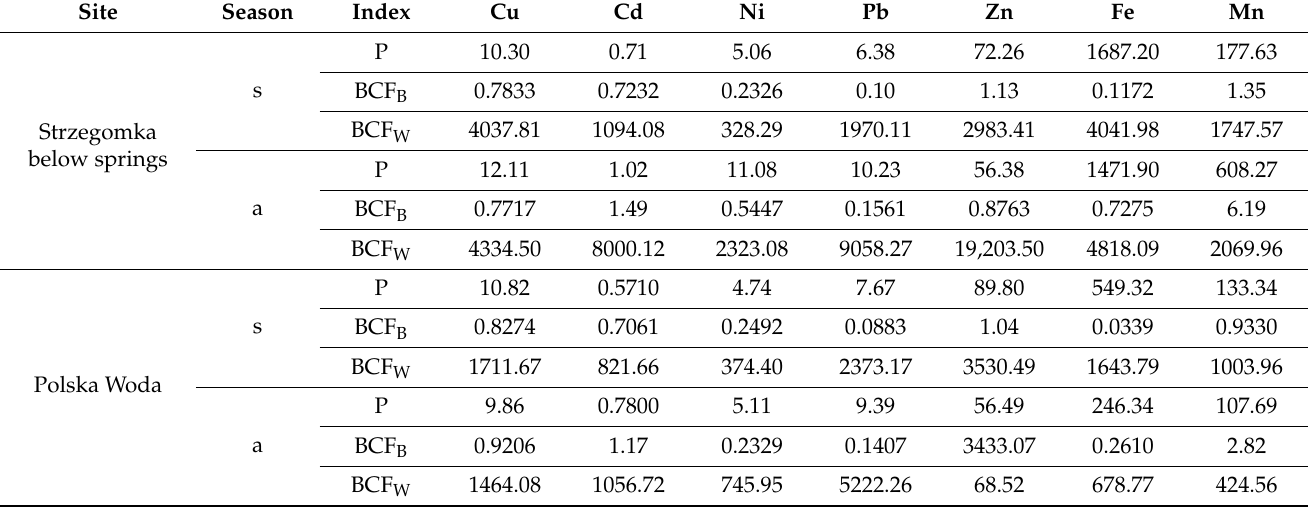
Table 7. Metals (mg · kg − 1 ) and metal bioaccumulation factors relative to water (BCF W ) and